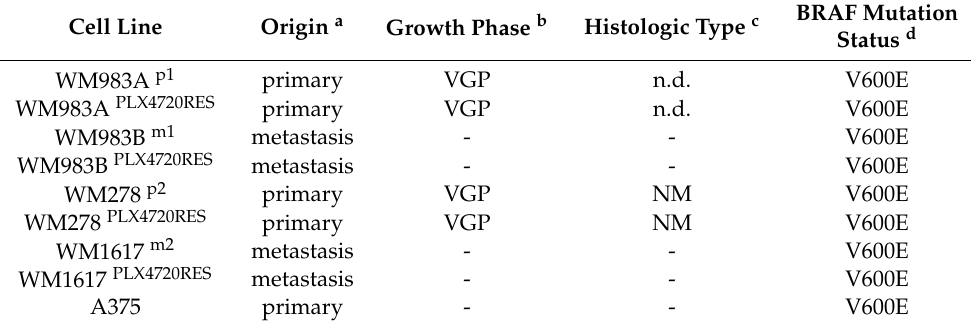
Table 1. Characteristics of human melanoma cell